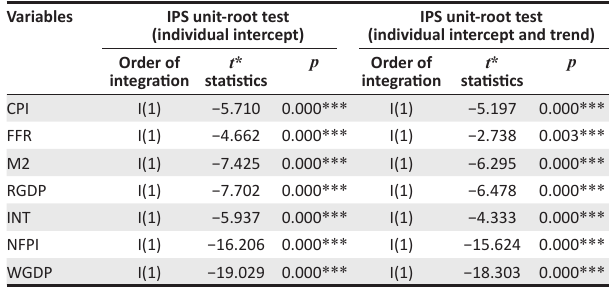
TABLE 1b: Levin, Lin and Chu, Im, Pesaran and Shin and Augmented Dickey– Fuller unit root tests. Variables